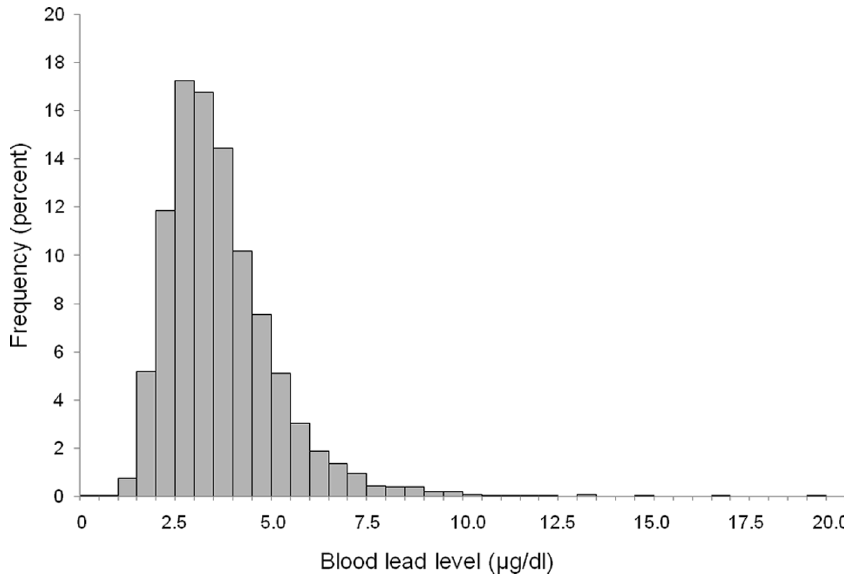
Figure 1. Frequency distribution of blood lead levels in pregnant women (n=4285).